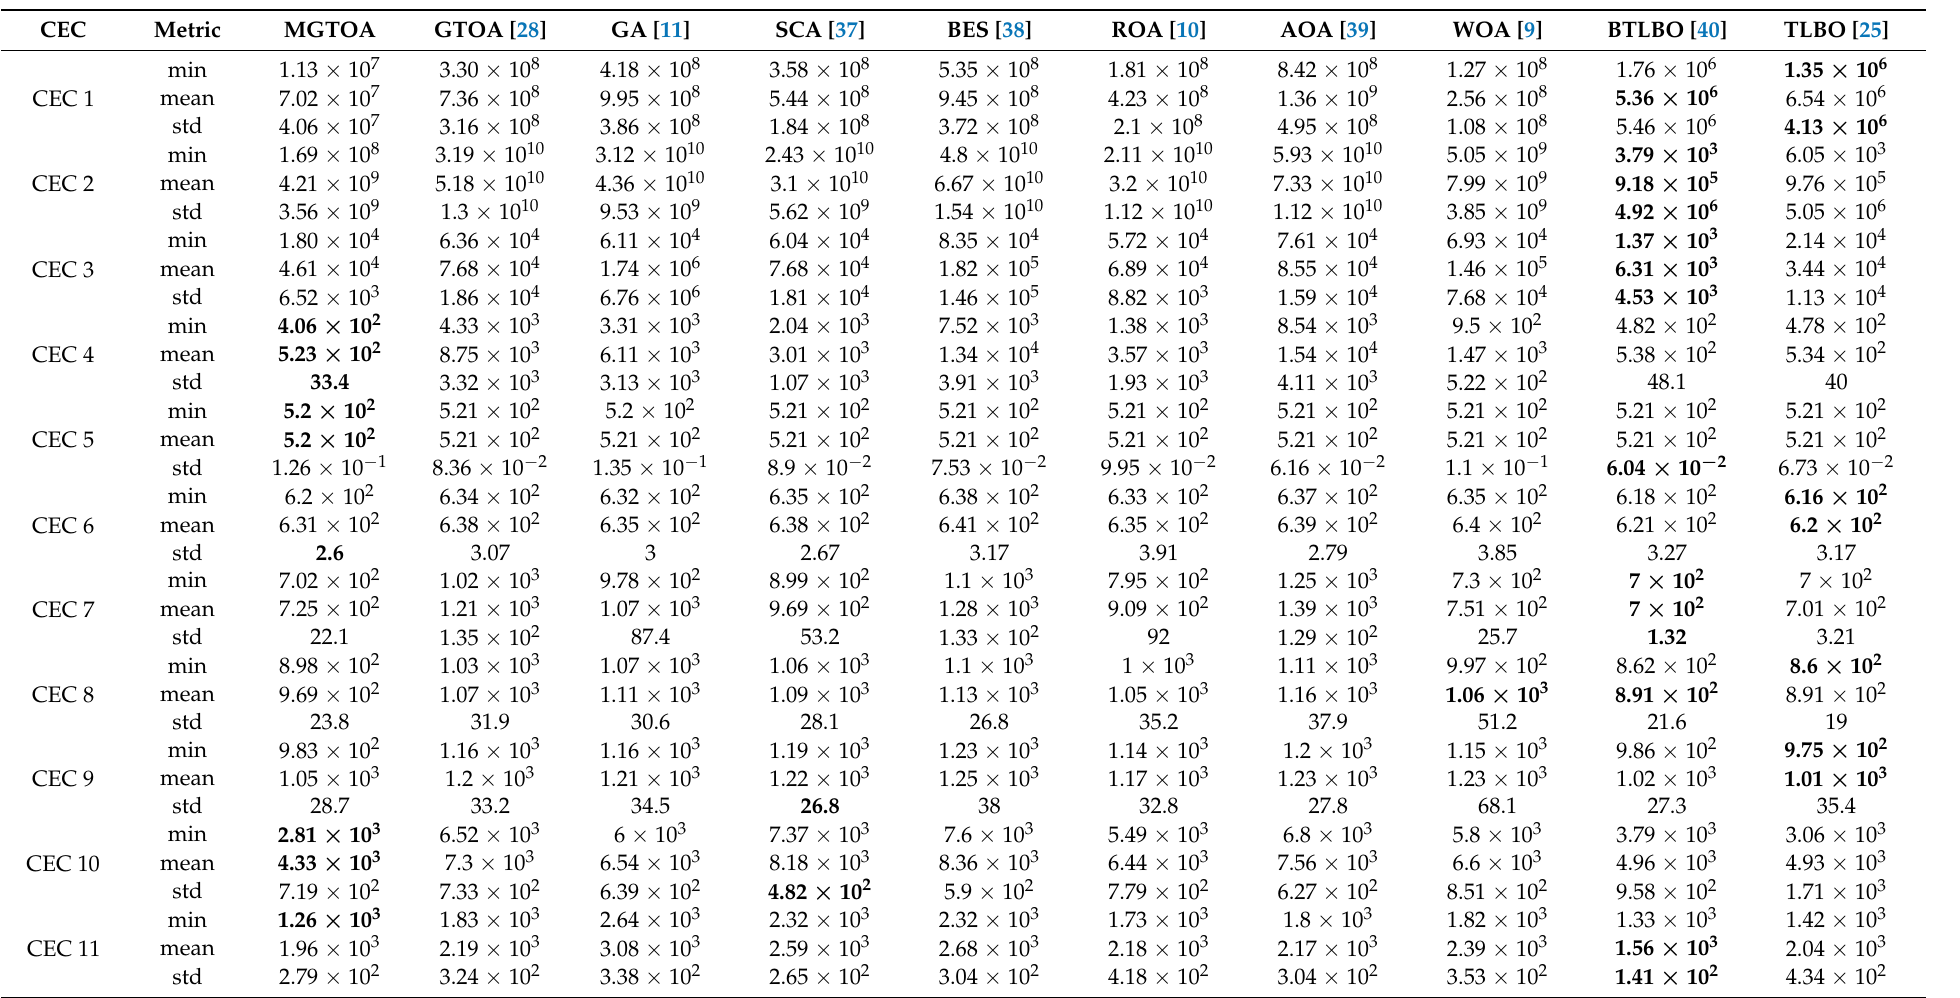
Table 8. Results of algorithms on the CEC2014 test